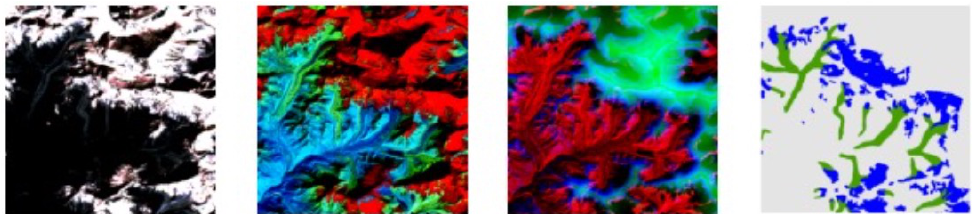
Figure A3. An example of input channels and output labels. We visualize the nine input channels (first three panels) in groups of three and the output labels (last column). In the last panel, blue, green and gray represent clean-ice glaciers, debris-covered glaciers and background,